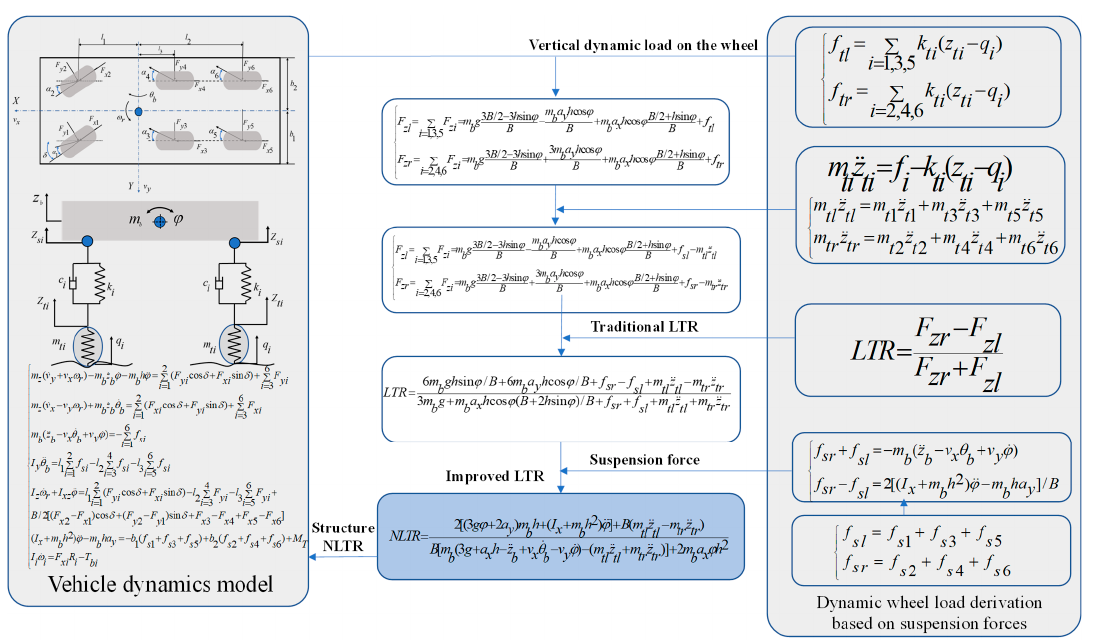
Figure 2. Algorithmic flow of the new rollover evaluation index. The traditional indicator, RI2 [24], is Equation (14).